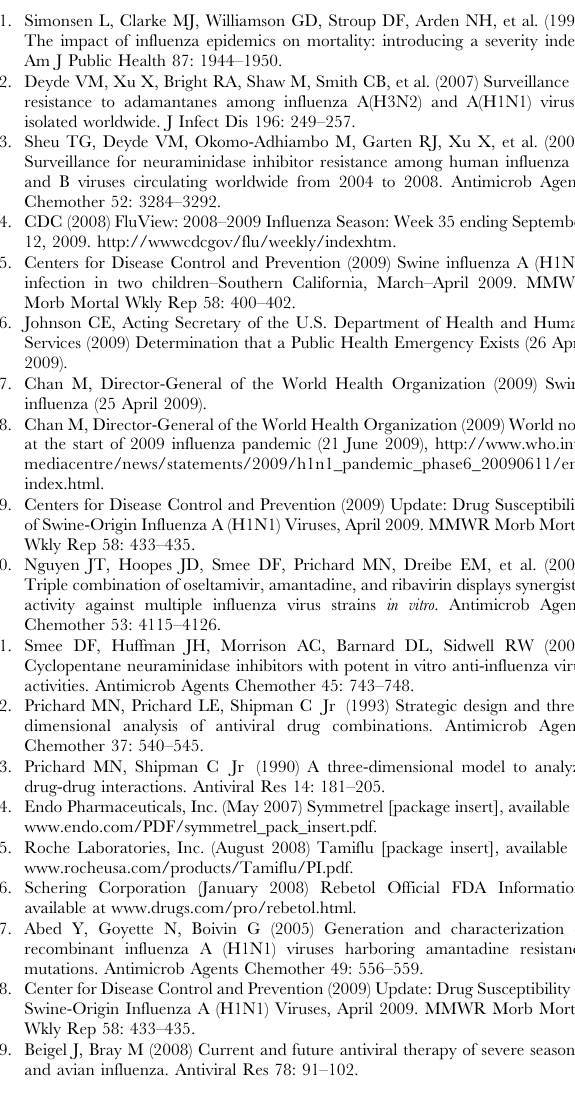
peramivir. Concentrations of each drug are indicated on the axes. Figure S3 Synergy of triple combinations of amantadine, ribavirin, and oseltamivir carboxylate against A/Mississippi/3/ 01(H1N1) H274Y (MS H274Y) and A/Hawaii/21/07 (H1N1) H274Y (HI H274Y) replication as determined by Neutral Red assay in MDCK cells. Values were derived from mean triplicate data and presented at 95% confidence. This experiment was repeated a total of six times with similar results. Blue areas indicate concentrations of each drug that are synergistic, gray areas indicate concentrations that are additive, and red areas indicate concentrations that are antagonistic. (A) MS H274Y; (B) HI H274Y. Concentrations of each drug are indicated on the axes, with each plane representing a different concentration of oseltamivir carboxylate. Figure S4 Viability of MDCK cells treated with the TCAD regimen. MDCK cells were incubated with the TCAD regimen at the highest concentrations of all three drugs used in the synergy